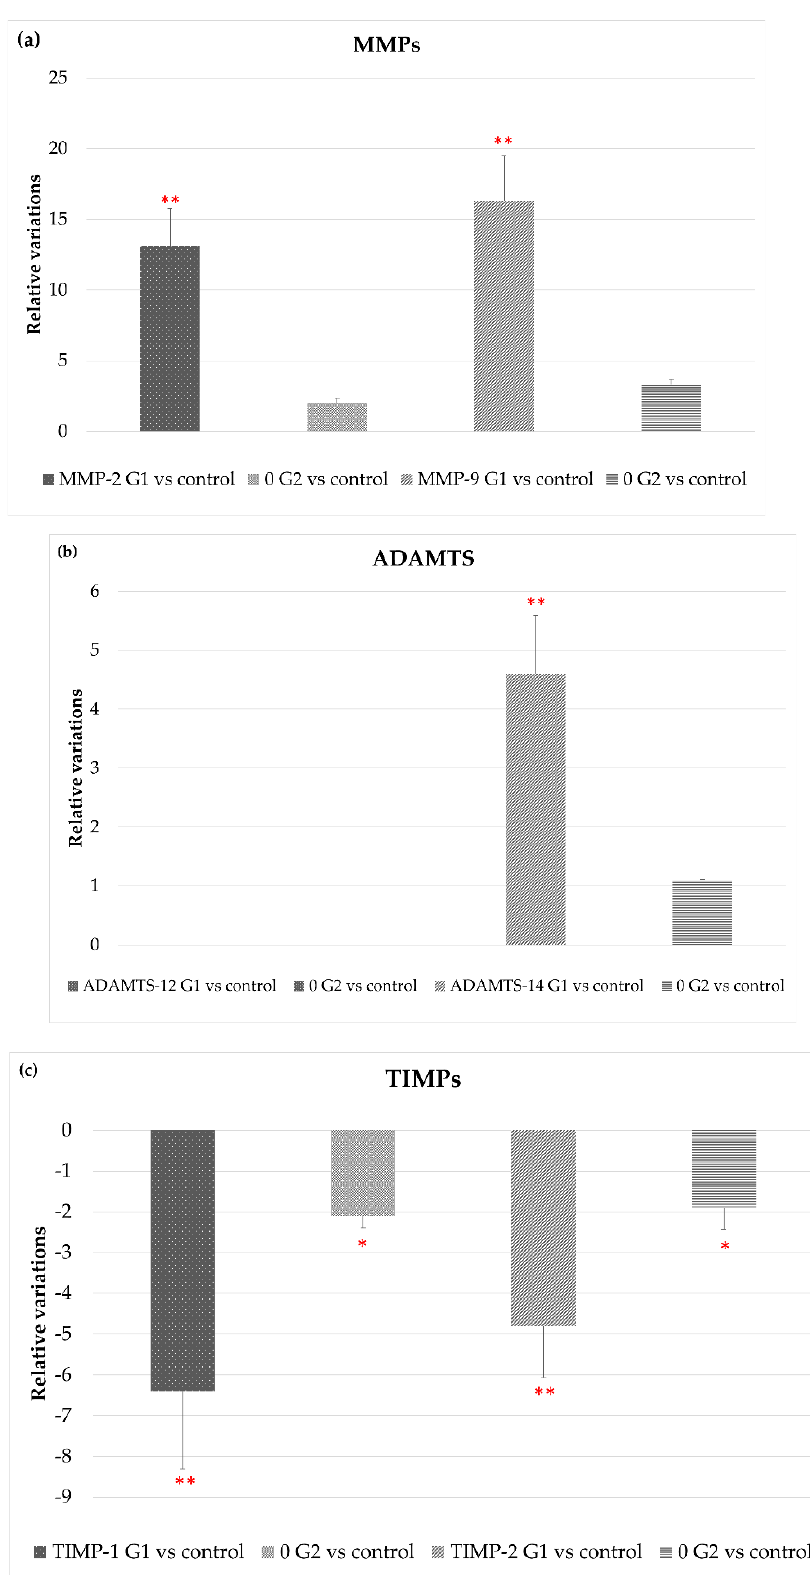
9 of 23 Figure 3. Gene expression comparisons between group 1 vs. control and group 2 vs. control. ( a ) Anti-apoptotic gene ex- pression, ( b ) pro-apoptotic gene expression, and ( c ) gene expression of apoptotic-related enzymes. * p < 0.05; ** p < 0.01. 3.2.2. Extracellular Matrix Degradation: MMP/TIMPs System and ADAMTS Genes Figure 4 shows that exposure to LED-backlit tablet screen light without filter (group 1) entails an increase in MMP-2 and MMP-9 mRNA expression, suggesting an increase in the extracellular matrix (ECM) turnover mediated by these proteases. As for changes in TIMPs expression, exposure to light emitted by LED-backlit tablet screens caused a de- crease of both TIMP-1 and TIMP-2. The use of the selective short-wavelength absorption